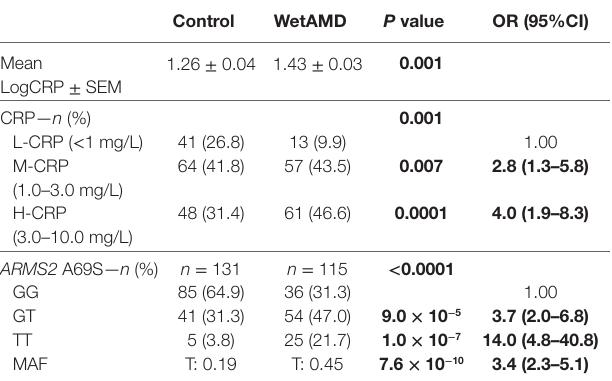
Table 2 | C-reactive protein (CRP) levels, number of subjects per CRP stratification, and A69S genotype for control and wetAMD groups. control